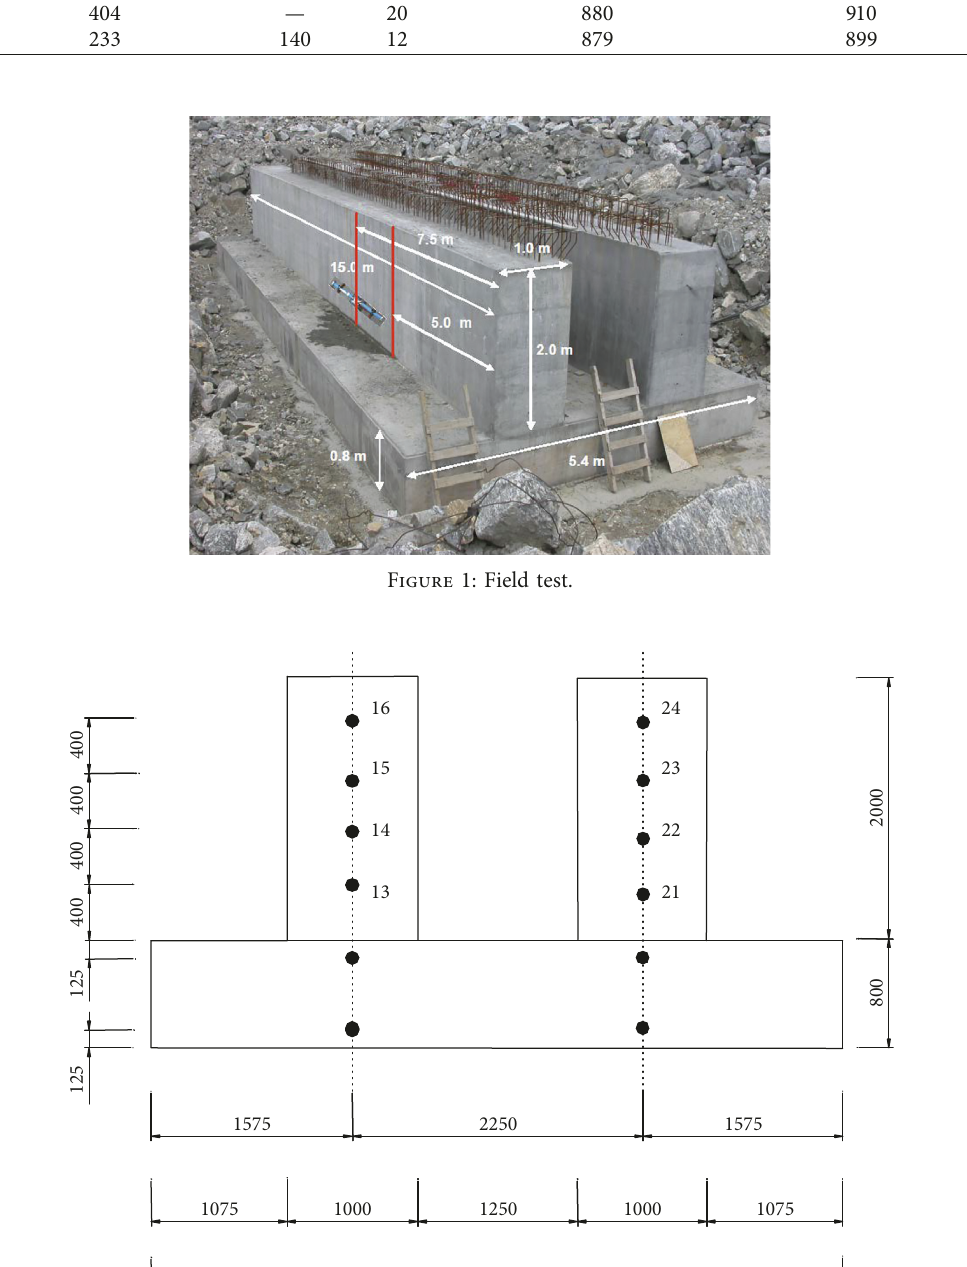
Figure 2: Middle cross section of the double-wall structure and the positions of the strain gauges (black dots) (dimensions in